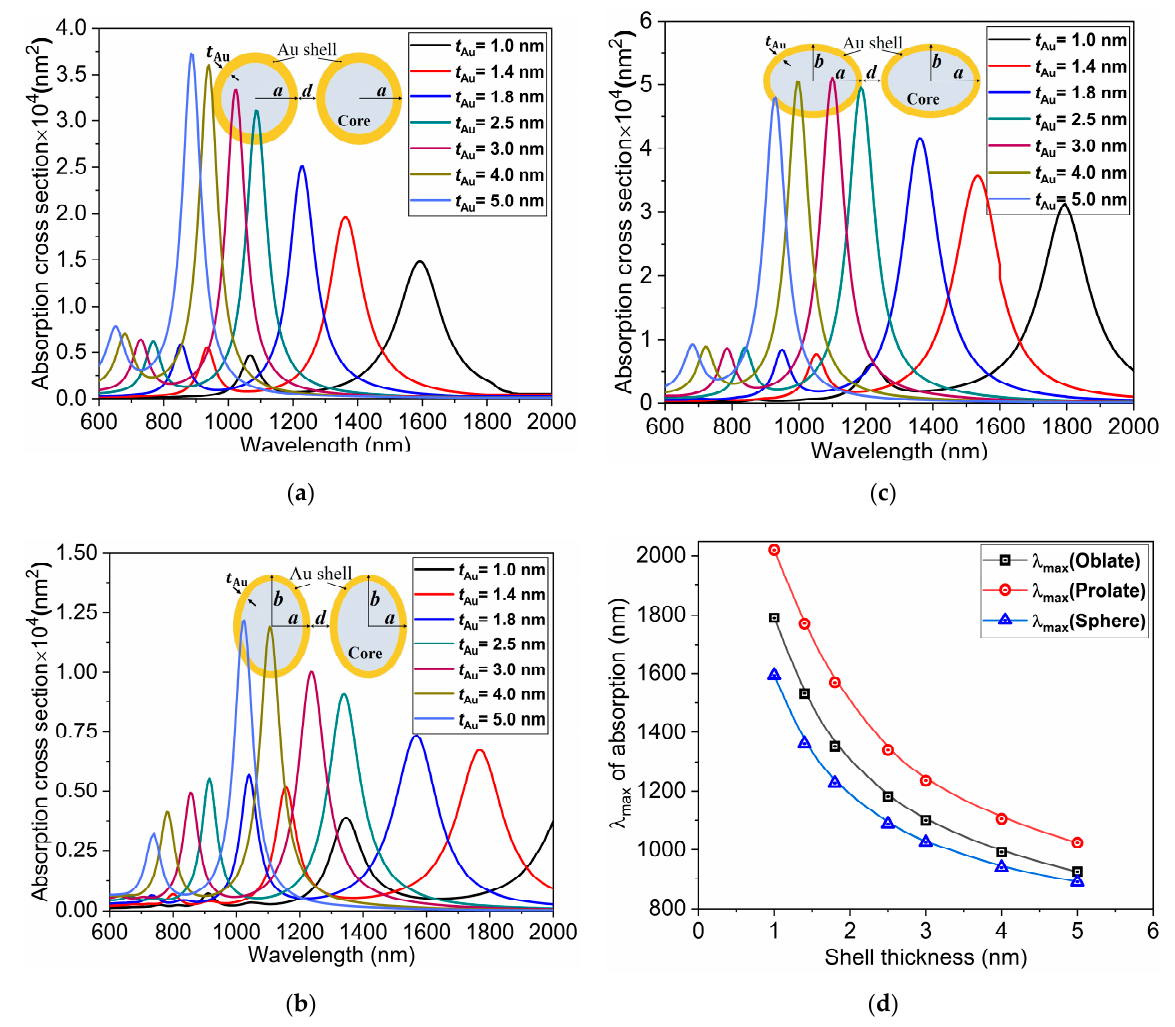
Figure 7. Absorption cross sections at different Au shell thicknesses for the ( a ) spherical, ( b ) prolate and ( c ) oblate Au core-shell nanostructures. ( d ) Variations of the LSPR peak position (𝜆 (cid:2923)(cid:2911)(cid:2934) ) with the Au shell thickness for the spherical (𝑟 = 20 nm, 𝑑 = 1 nm) and non-spherical (𝑟 (cid:2915)(cid:2916)(cid:2916) = 23 nm,𝑑 = 1 nm) Au core-shell nanostructures.